Question: Produce a descriptive caption suitable for publication.
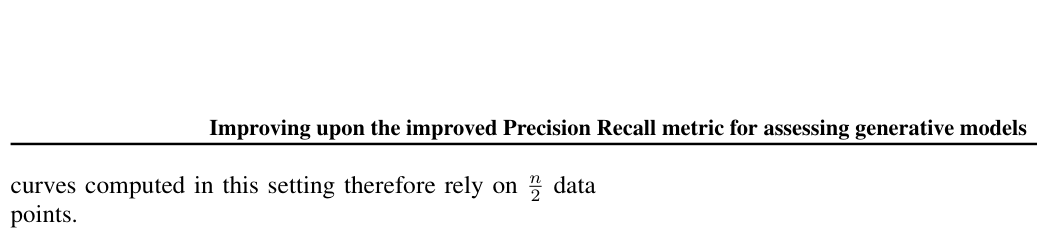
Answer: Illustration of the impact of splitting for P = Q. The setting is the same as Fig. 2 for a translation of µ = 0 between two Gaussian in dimension d = 64 (curves are aver- aged over 3 random samples). The Ground-Truth PR curve ( - -GT) is compared to empirical estimates from various NN-classifiers: –IPR, –KNN, –PARZEN, and –COVERAGE. Top reports results without splitting : as reported in the lit- erature, estimated extremal precision and recall values are not equal to 1, contrary to the ground-truth. Bottom curves, obtained with a 50% splits, are very close to the ideal curve.